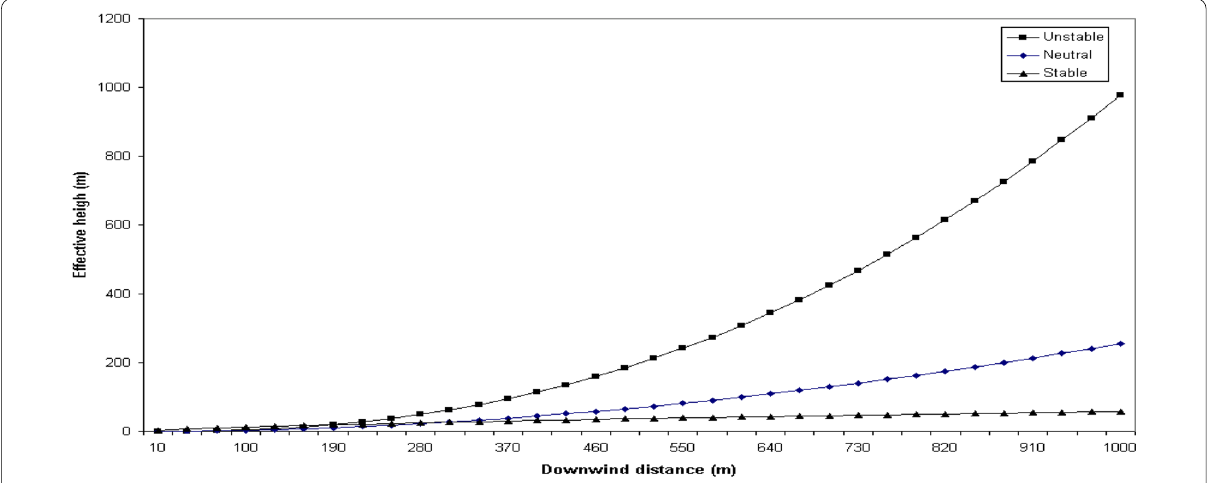
Fig. 8 The relation of "H" for Cs‑137 via "x" when H depends on "x"